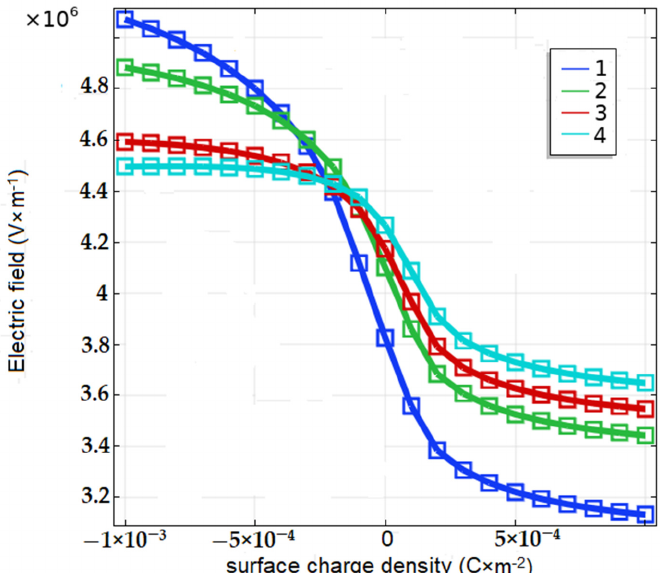
Figure 5. The dependence of electric field on the surface charge density ρ at different levels of p-dopant. Cutpoint X = 2.3 µ m, Y = 0.5 µ m. GaAs, p -type, cm − 3 : ( 1 ) 10 12 , ( 2 ) 10 14 , ( 3 ) 5 × 10 14 , ( 4 ) 10 15 .